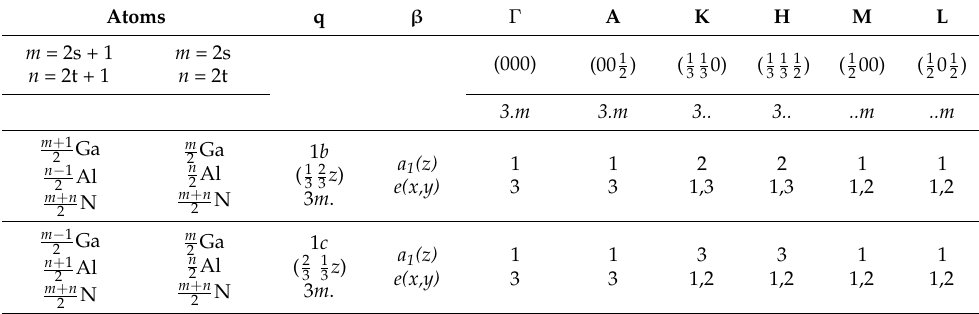
Table 2. Phonon symmetries in the (GaN) m /(AlN) n SL’s with the space group P3m1 ( m + n =